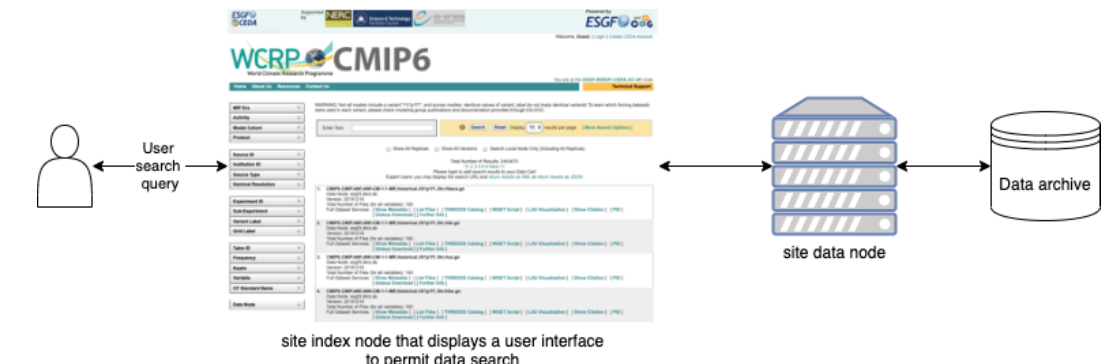
Figure 3. The ESGF data search and delivery system